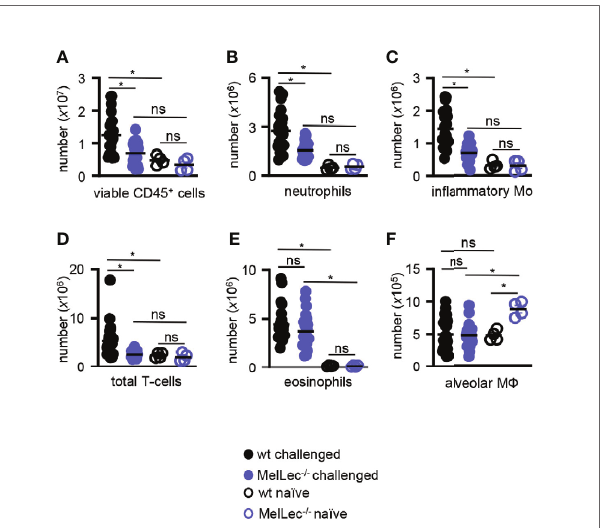
FIGURE 2 | MelLec-de fi cient mice have reduced pulmonary pathology. (A) Representative Haematoxylin and Eosin (H&E) (top panels) and Periodic Acid Schiff (PAS) (bottom panels) stained lung sections from wild type (wt) and MelLec -/- mice, as indicated, on day 23 following allergic sensitization and challenge with live Aspergillus fumigatus conidia. Scale bars represent 100 m m. Histological quanti fi cation of bronchial (B) in fl ammation (n=3; WT means 8644, 11892 and 7880 m m 2 ; KO means 7104, 6176, 4081 m m 2 ; mean difference is n.s.), (C) wall thickness (n=3; WT means 7.0, 7.4 and 6.1 m m; KO means 5.2, 3.5, 4.0 m m; mean difference p<0.05) and (D) goblet cell hyperplasia (n=2; WT means 53.1 and 78.4%; KO means 74.5 and 66.9%), versus naïve mice (n=2). Shown are pooled data (with mean) of fi ve representative bronchioles from the indicated number of mice. *p<0.05, n.s., not signi fi cant, determined from pooling the data of all samples from the mice. Statistical signi fi cance was determined using ANOVA (B, C) and student t-test (D)